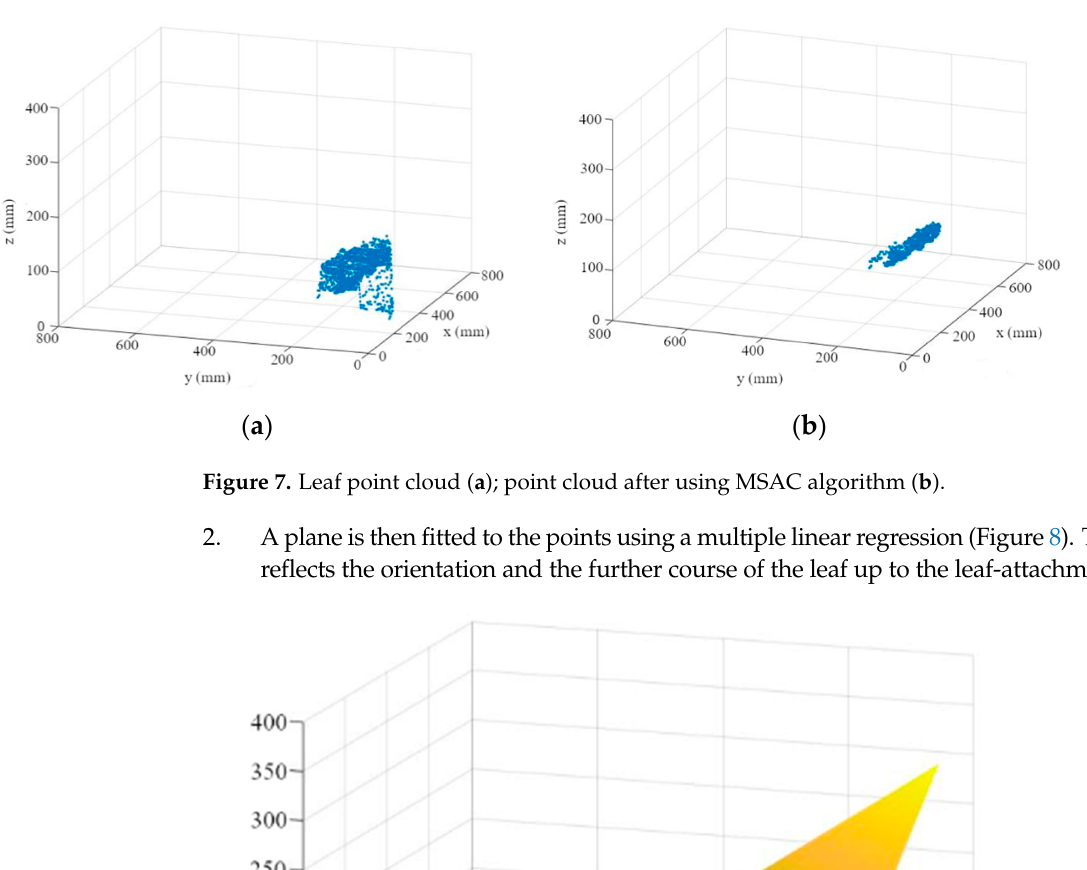
8 of 18 Figure 6 . Leaf point cloud with marked leaf-attachment point (big green point) and leaf end-points (*) .